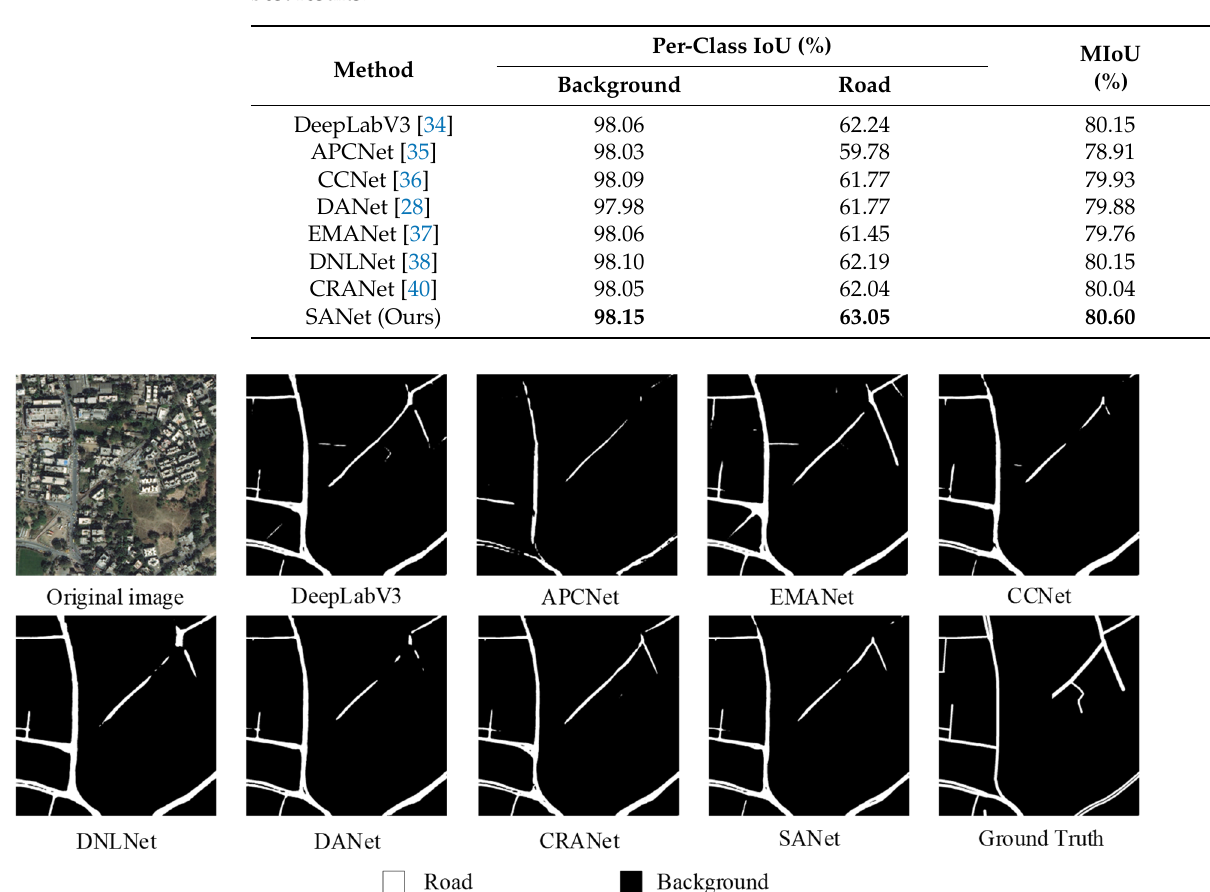
Table 8. Comparison with other methods based on the DeepGlobe dataset. Data in bold are the best results.